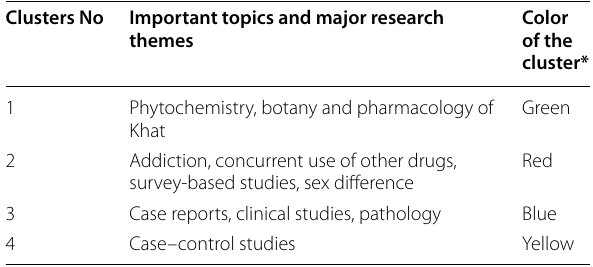
Table 4 Keywords’ co-occurrence and important topics and major research